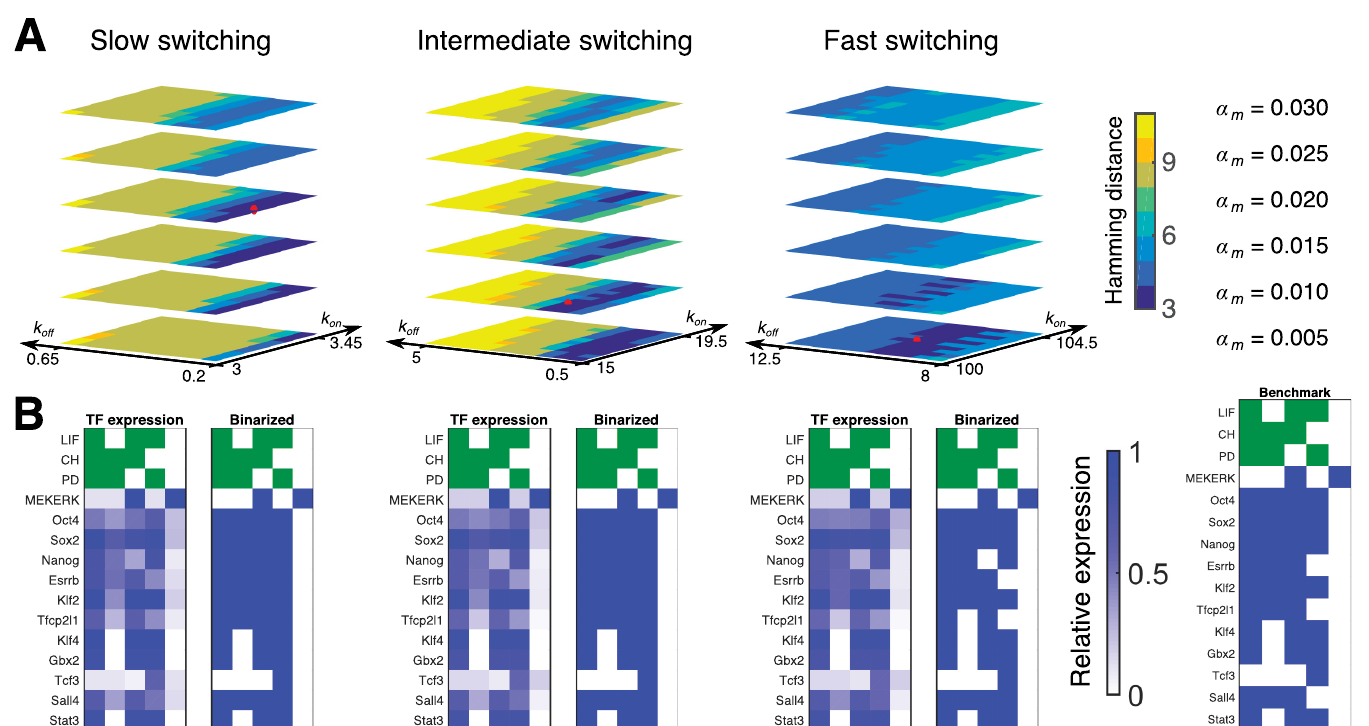
Fig 2. PDMP stochastic simulations identify three genetic switching regimes that are consistent with experimental data. When switching is slow, intermediate, or fast we find certain parameters which closely match the experimental results obtained by Dunn et al. [16]. The consistency of our model with experimental results is measured using a Hamming distance—a measure where one counts the number of discrepancies between the binary expression of each TF for both cases. (A) Shown are the identified regions in parameter regimes that minimize Hamming distance. There are three free parameters: the binding rate k on , unbinding rate k off , and basal transcription rate α . For slow switching, the parameters are k on = 3.2, k off = 0.2, α = 0.02; for intermediate switching, k on = 16, k off = 1.5, α = 0.01; for fast switching, m m m k on = 102, k off = 10, α m = 0.005. The selected parameter sets are presented as red dots in the landscapes in the upper panel, hereby referred to as the slow, fast and intermediate parameter regimes. (B) Comparison of computed and discretized gene expression profiles with those of the experiments (Benchmark panel) [16].